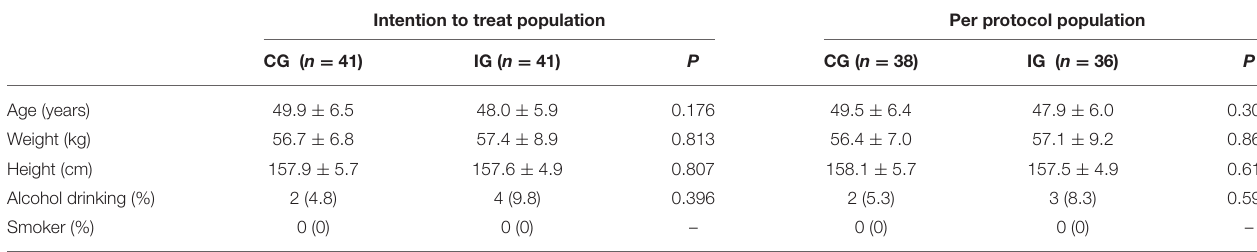
TABLE 1 | Baseline characteristics of the study subjects.